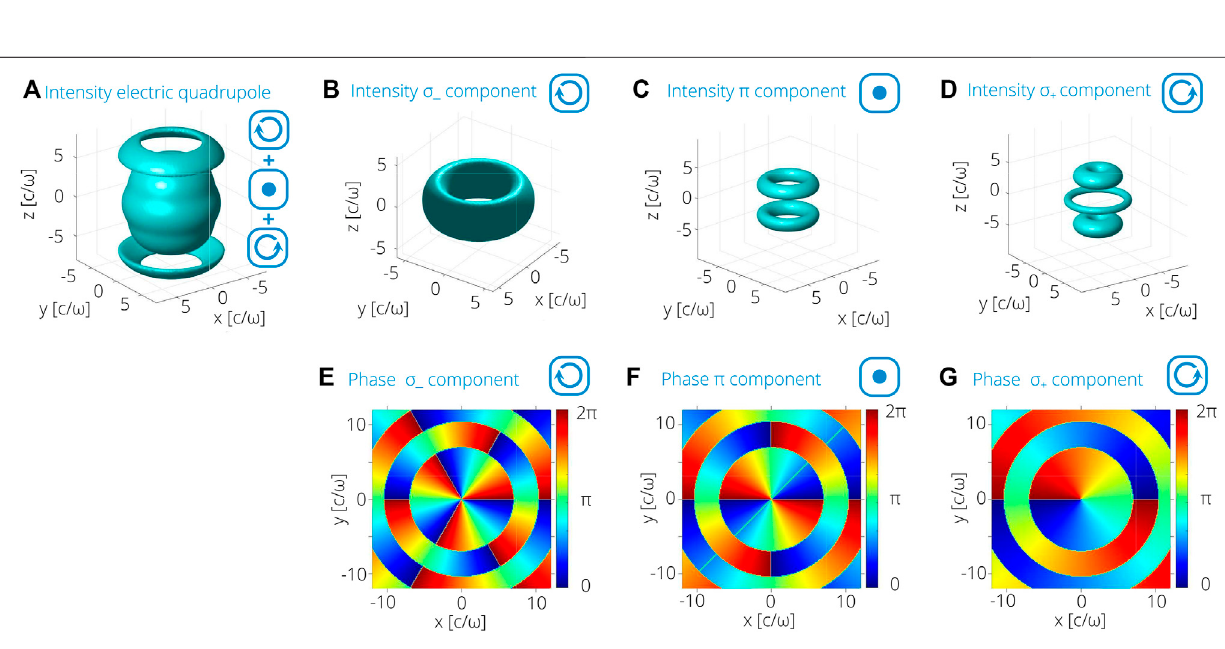
FIGURE 2 | Isosurfaces of an electric dipole Y ( E ) 11 spherical wave at 40% of the intensity divided into: (A) total intensity; (B) σ − polarization component; (C) π polarization component; and (D) σ + componentsof the polarization. In (E – G) the phase distributions at the z = 0 plane are plotted for different polarization components.